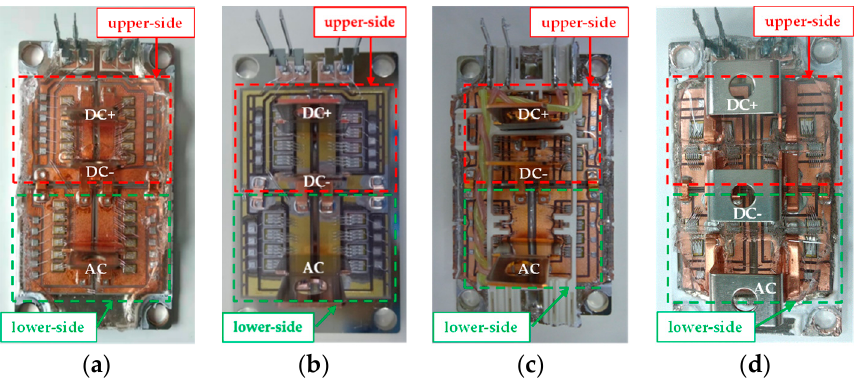
Figure 2. The inner structure inside the developed SiC power modules: ( a ) module_A, ( b ) module_B, ( c ) module_C, ( d ) module_D.